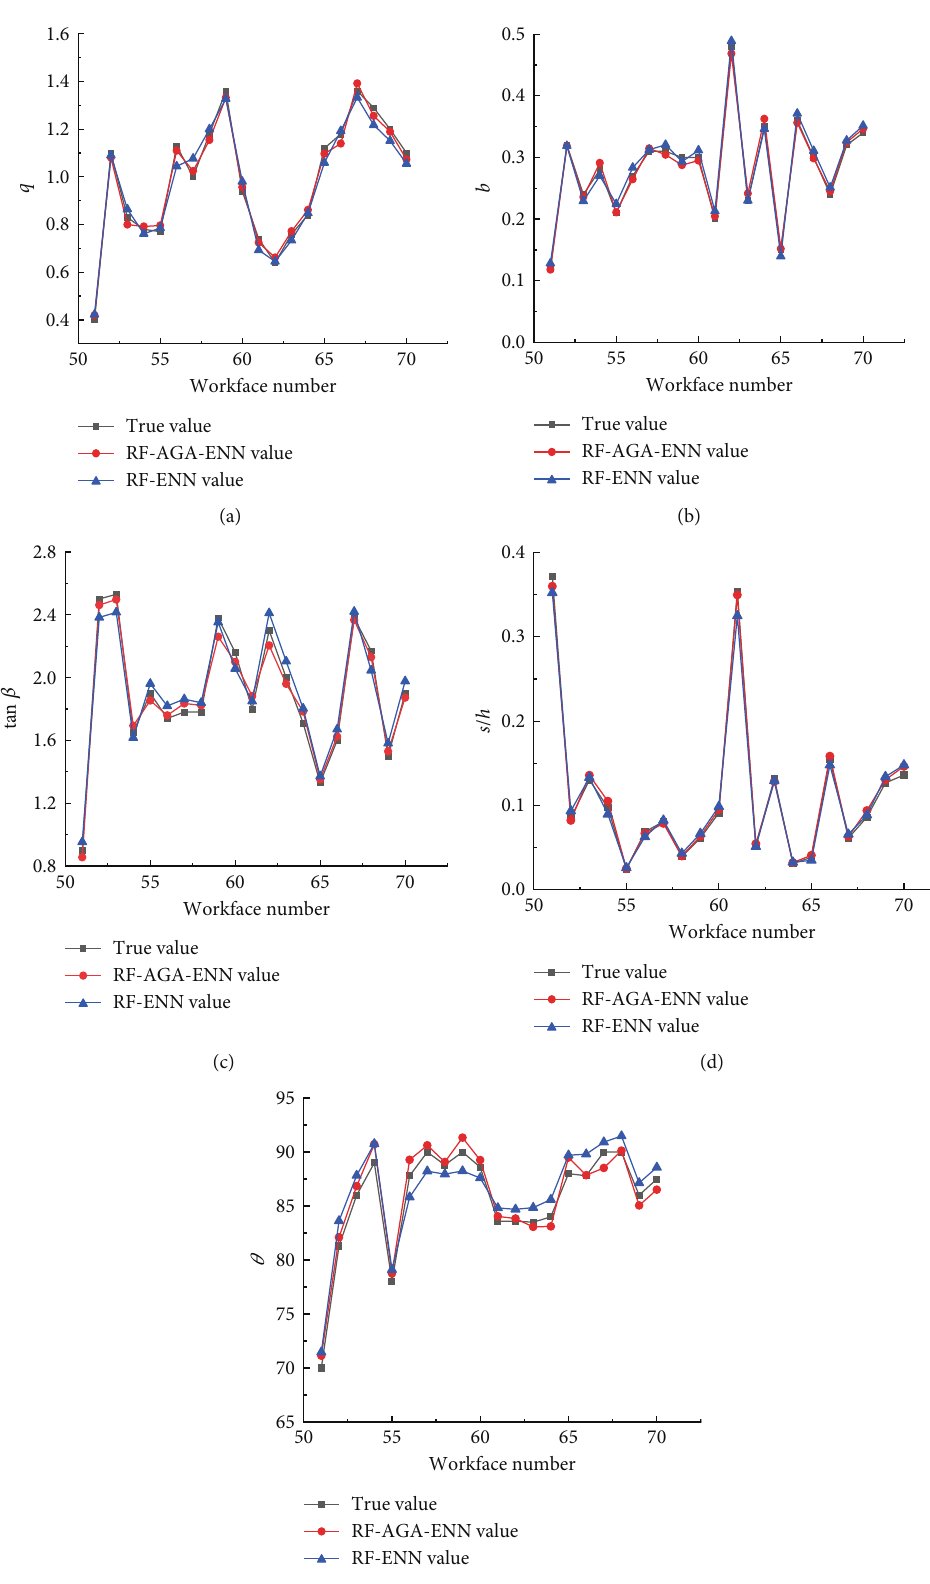
Figure 6: Comparison of ENN model prediction values before and after AGA